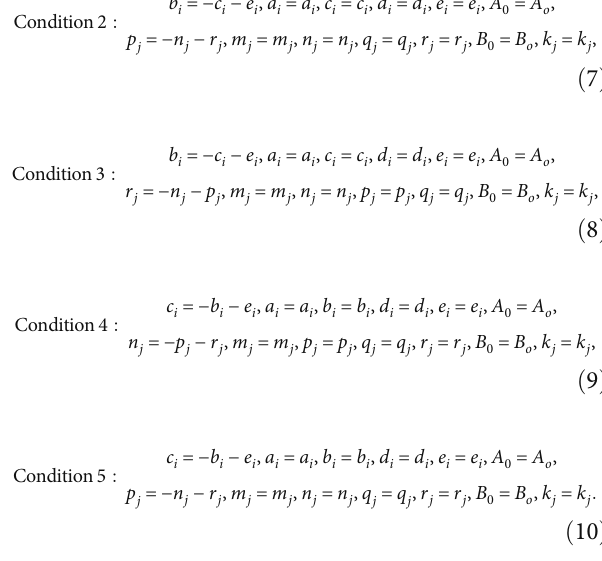
= n = q = r = 3, m 1 1 1 1